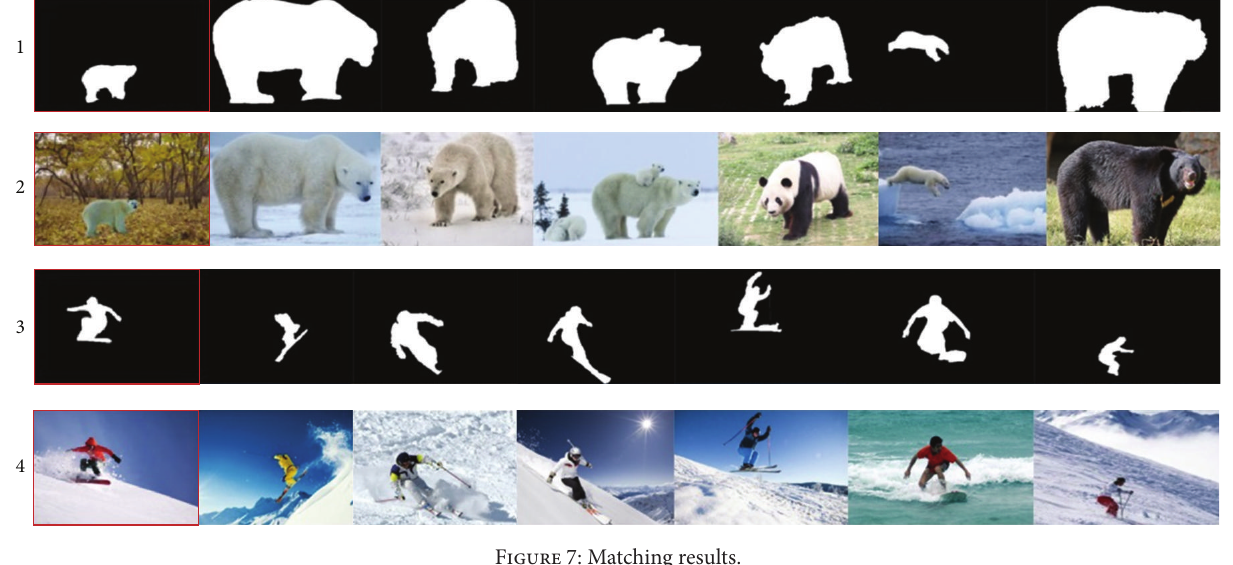
Figure 7: Matching results.